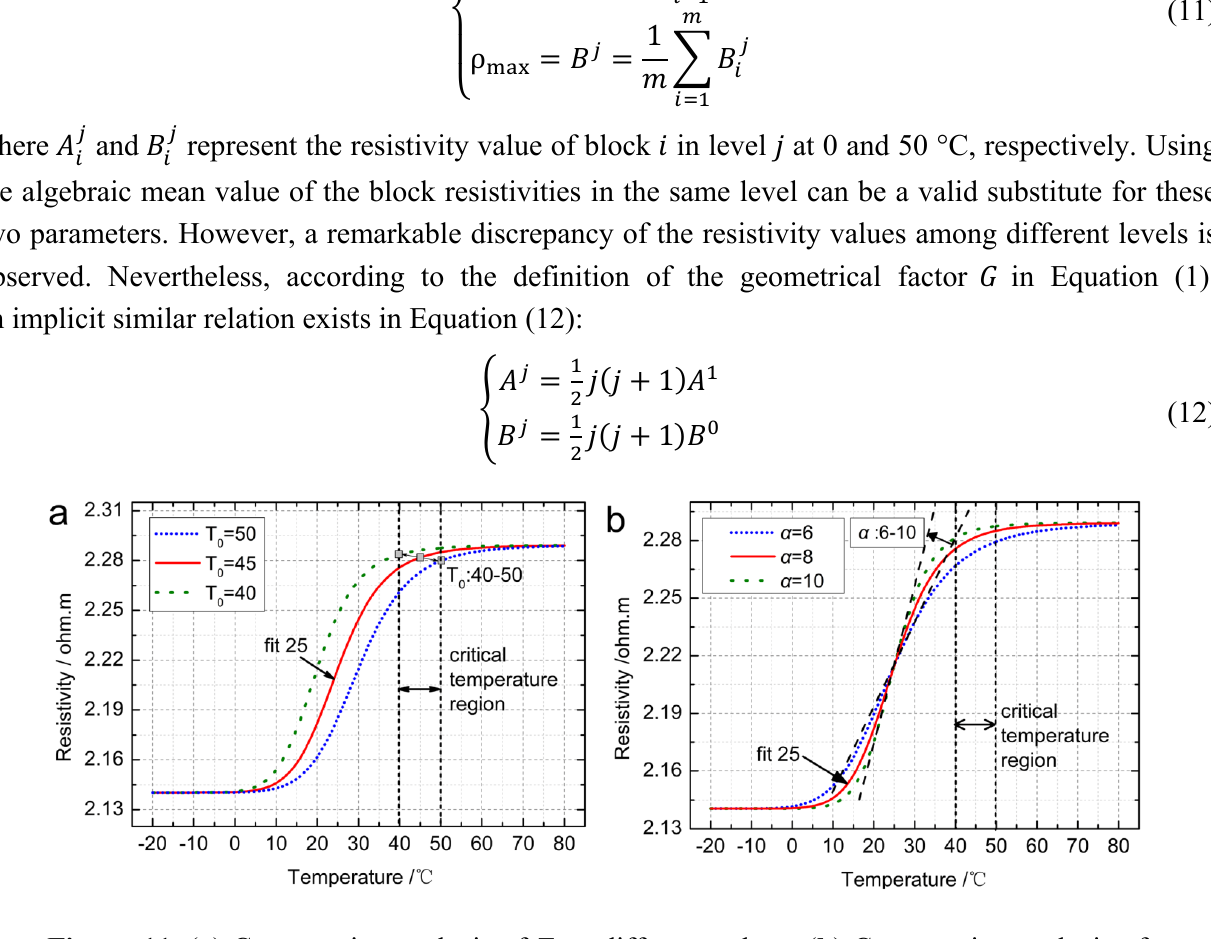
Figure 11. ( a ) Comparative analysis of T 0 at different values; ( b ) Comparative analysis of α at different values. The values are selected from Tables 3 and 4. The logistical fit line of the block 25 in Figure 7 is chosen as the reference